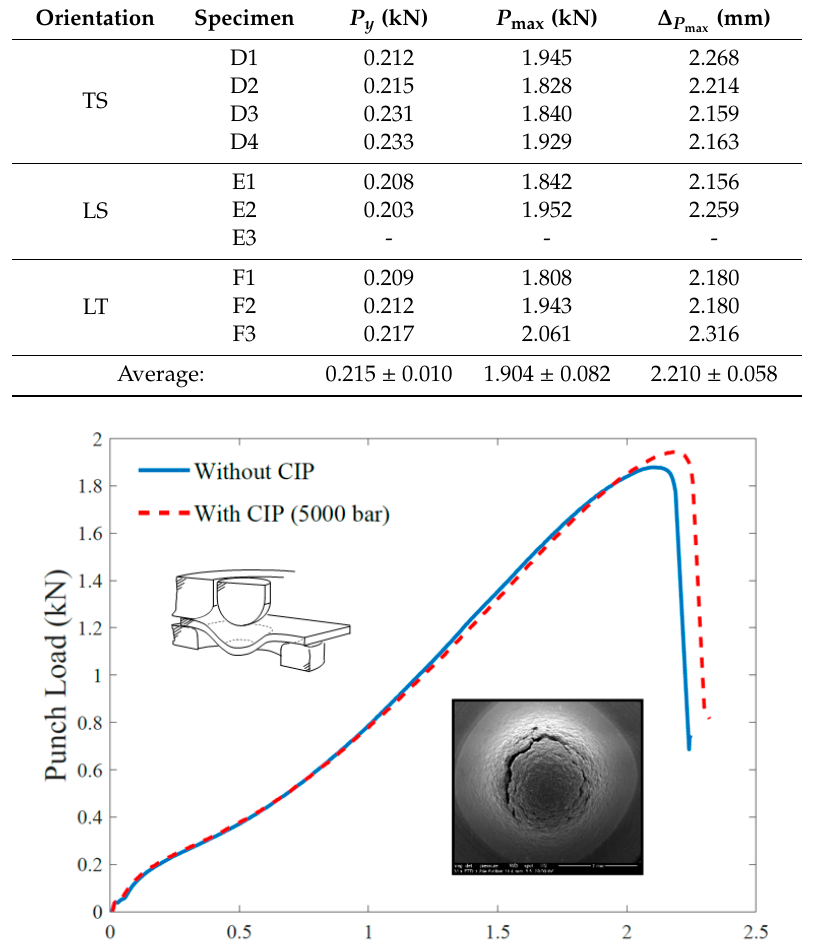
Table 4. Characteristic SPT parameters P y , P max and ∆ P